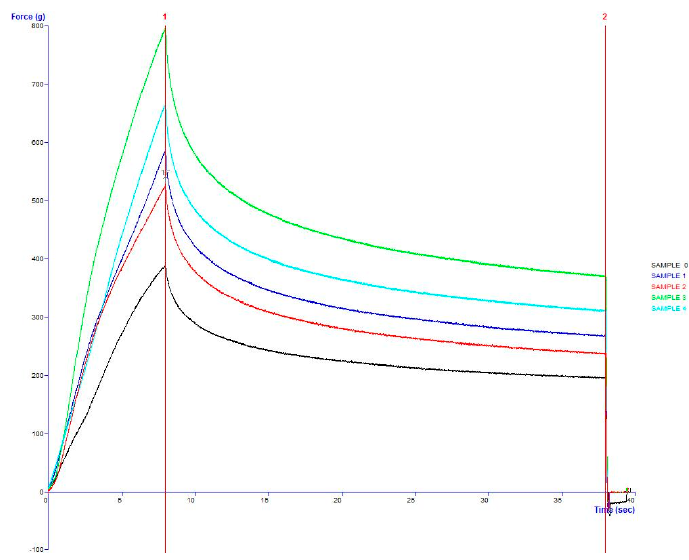
Figure 14. Firmness of sponge cakes in accelerated condition 37 °C.